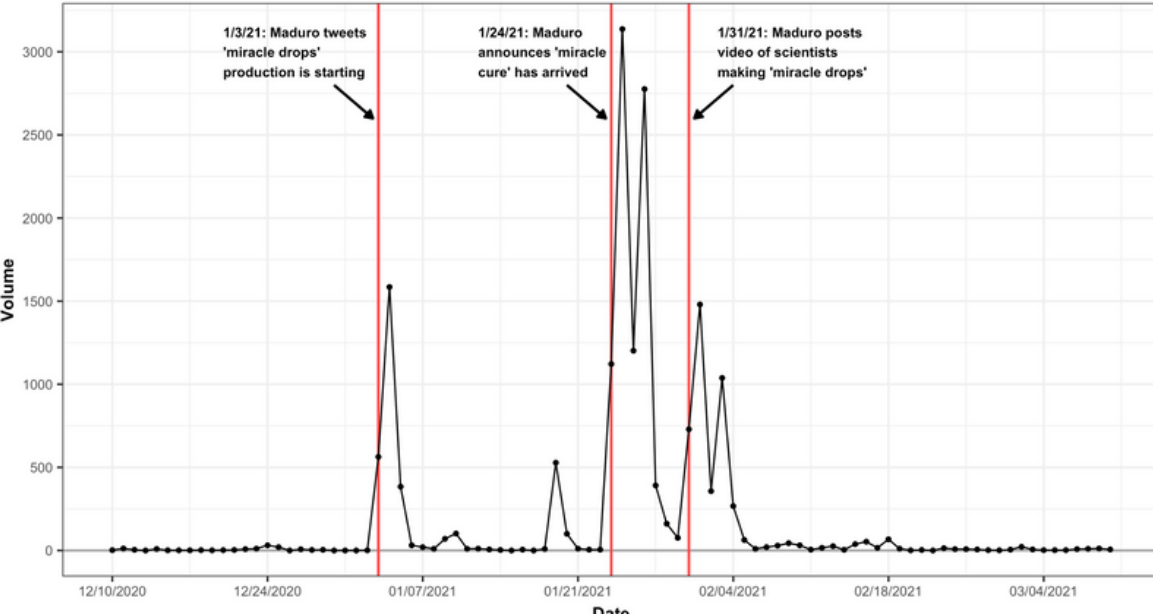
Figure 3. Time-series plot for ‘miracle cure.’ Maduro refers to President Nicolás Maduro of Venezuela. From COVID hashtag stream (December 2020– March